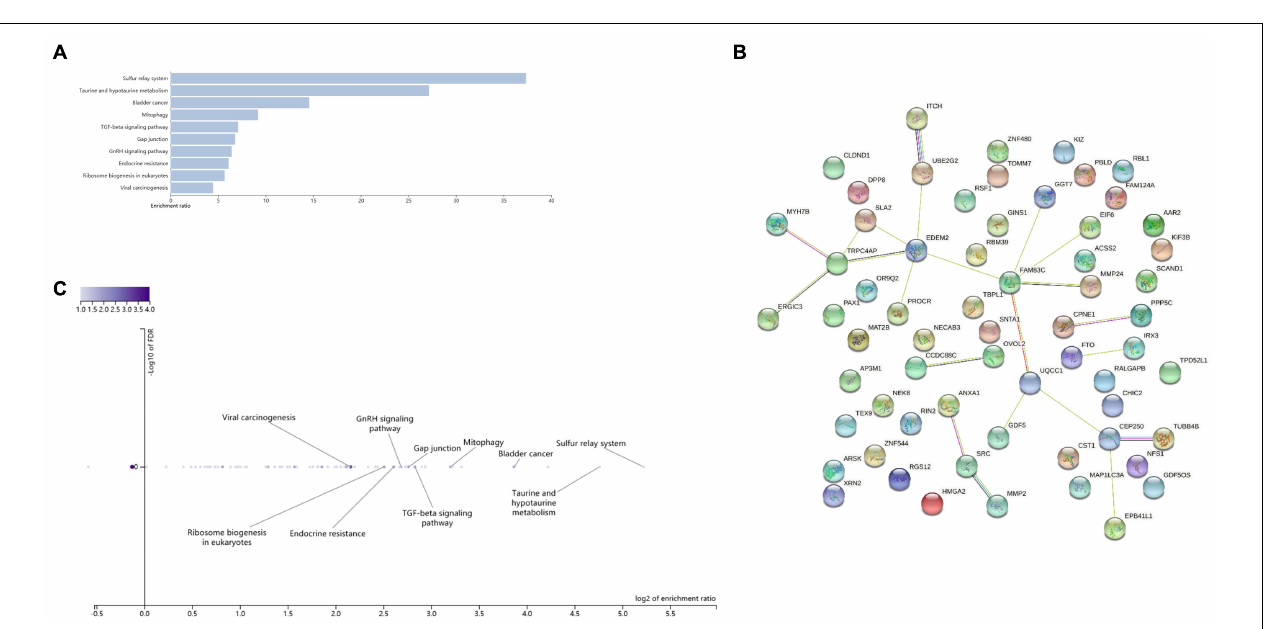
FIGURE 5 | GO enrichment analysis of significant SNPs probability regulating associated genes expression. (A) Red, blue, and green bars indicate biology progress, cellular components, and molecular function categories, respectively. The numbers above the bar charts indicate the number of genes in each of the biological categories; (B) Bar charts of GO enrichment analysis; (C) Volcano plot of GO enrichment analysis. For more knowledge about GO enrichment, please check the website http://geneontology.org/docs/go-enrichment-analysis/.